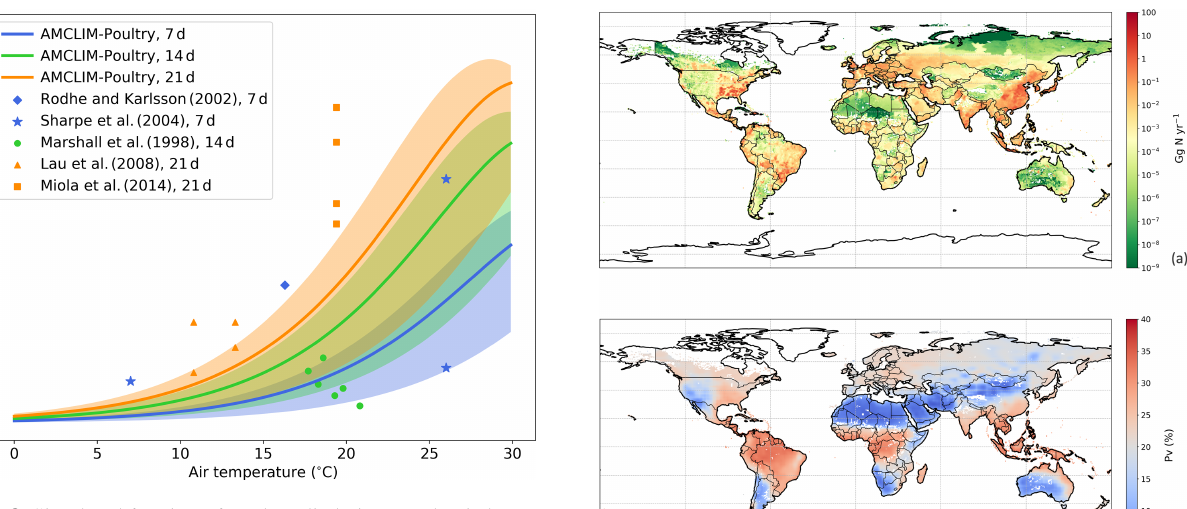
Figure 8. Simulated fraction of total applied nitrogen that is lost as NH 3 -N ( P V ) as a function of air temperature (in degrees Celsius) by the AMCLIM–Poultry for simulating periods of 7, 14 and 21d, and a comparison with experimental studies that measured NH 3 N loss for 7, 14 and 21d. Simulations are conducted for rain-free conditions, where shaded areas indicate the range for simulations from 20% to 100% relative humidity. The measured figure of 5% volatilization at 27 ◦ C by Sharpe et al. (2004) was associated with high precipitation not representative of these simulations.